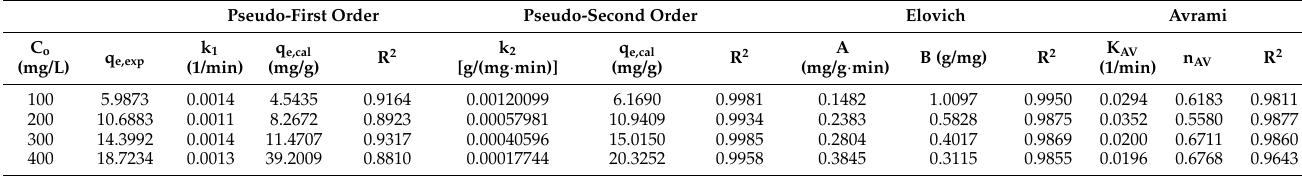
Table 4. Kinetics constants for the adsorption of CPC onto AOS at 20 ◦